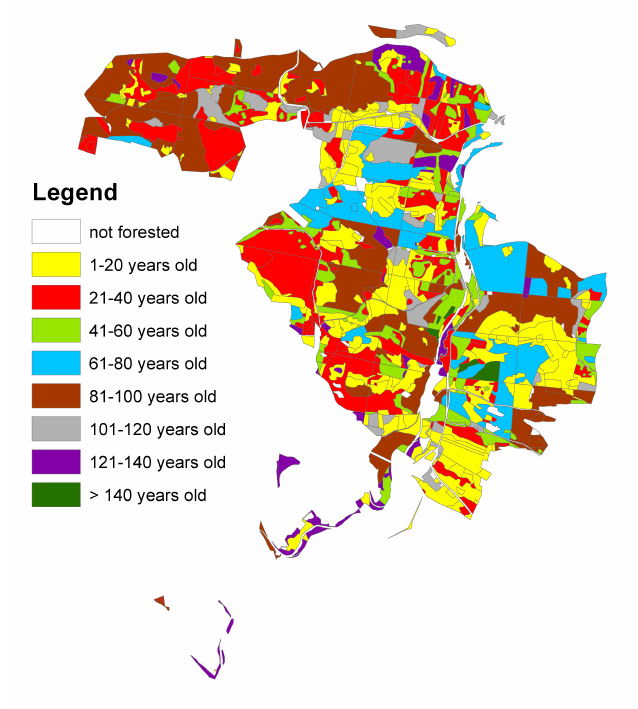
Figure 5. The forest stands map with colored age classes (20 years age class